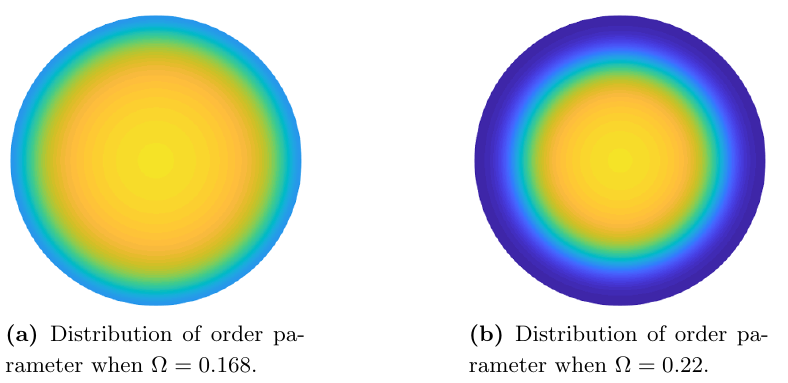
Figure 2. Initial Con(cid:12)gurations with space coordinates